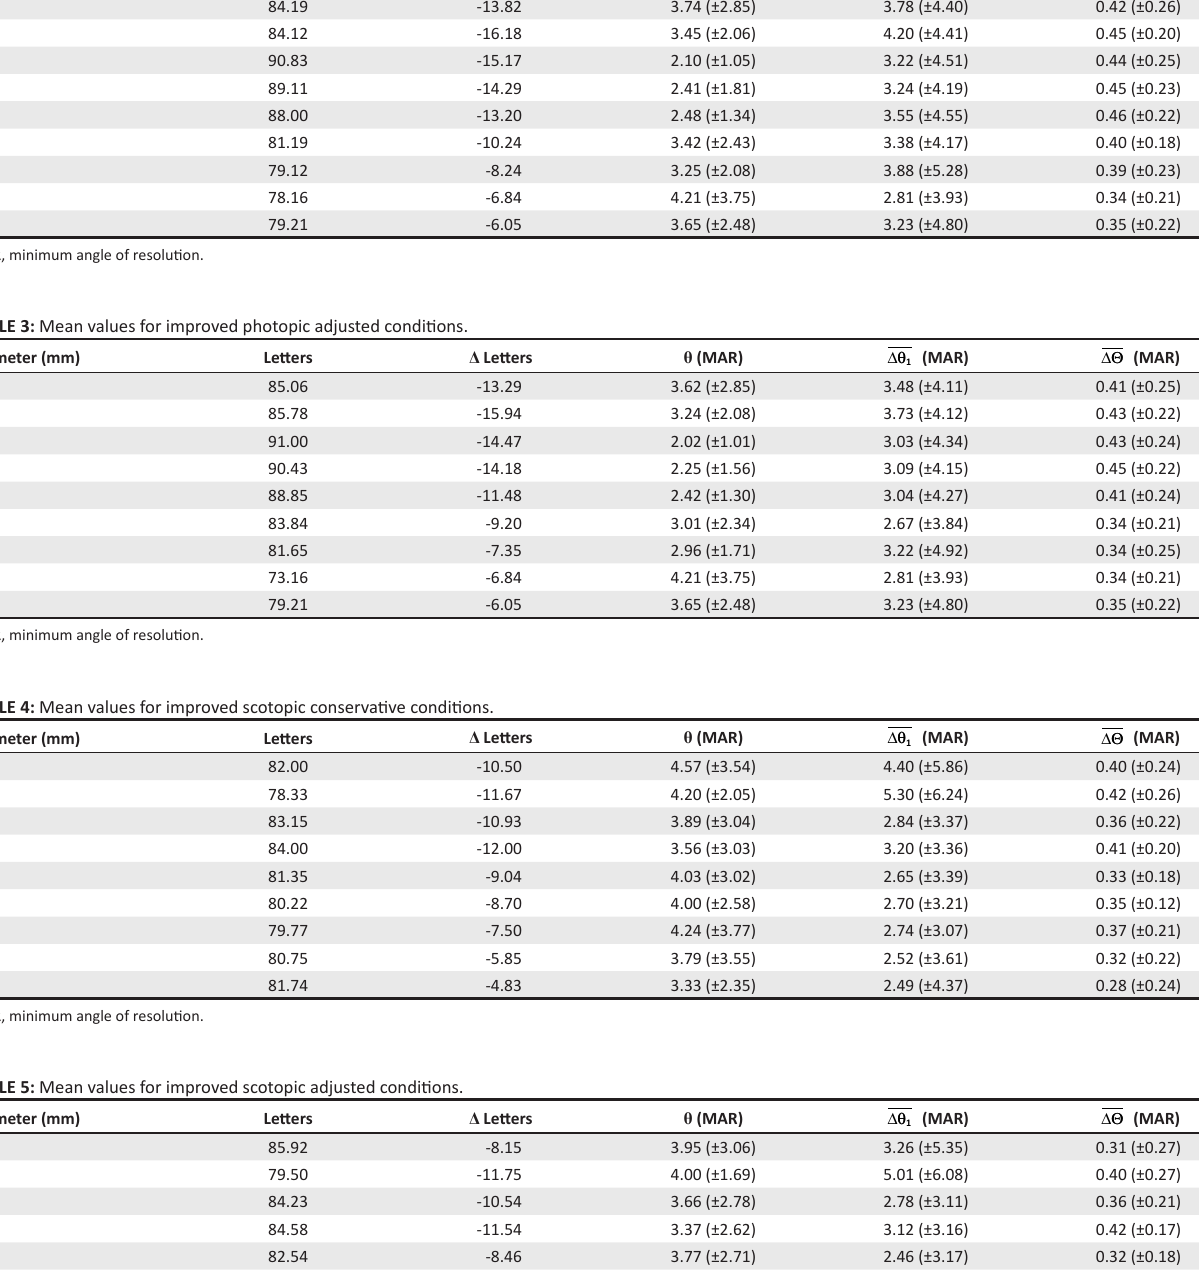
TABLE 2: Mean values for improved photopic conservative conditions. Diameter (mm)